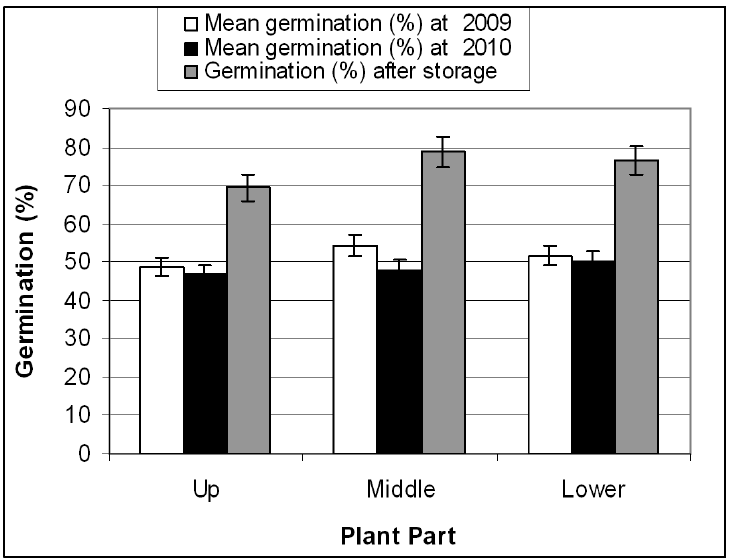
Fig. 3. Effects of different parts of plant and seed storage on germination in 2009 and